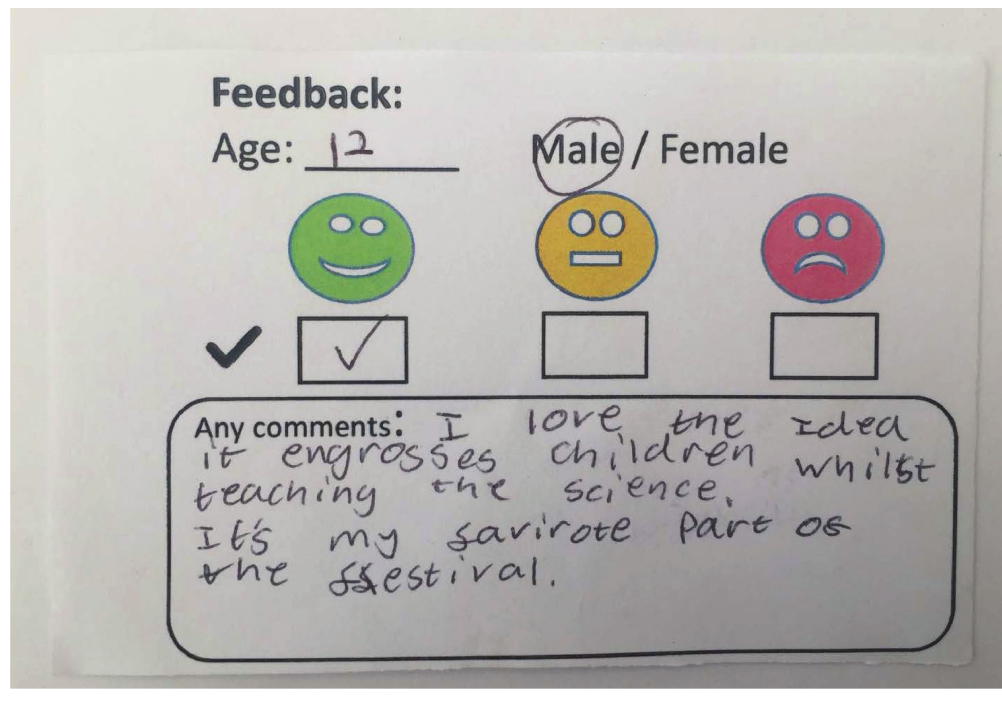
Figure 5: An example of a feedback card returned at Geronimo Children’s Festival in